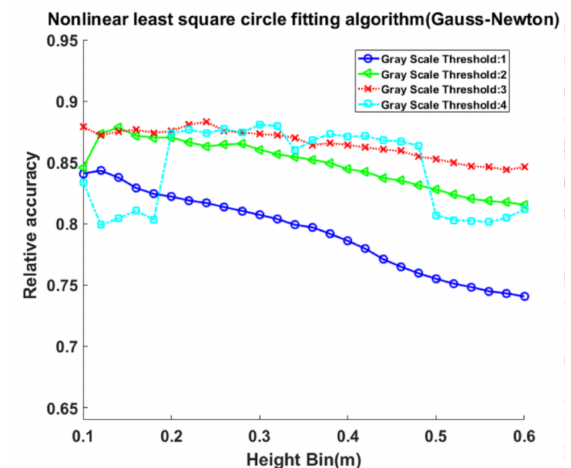
Figure 10. The relative accuracy of the nonlinear least square circle fitting algorithm (Gauss-Newton) under different height bins and gray scale thresholds in multi-scan mode of the natural secondary